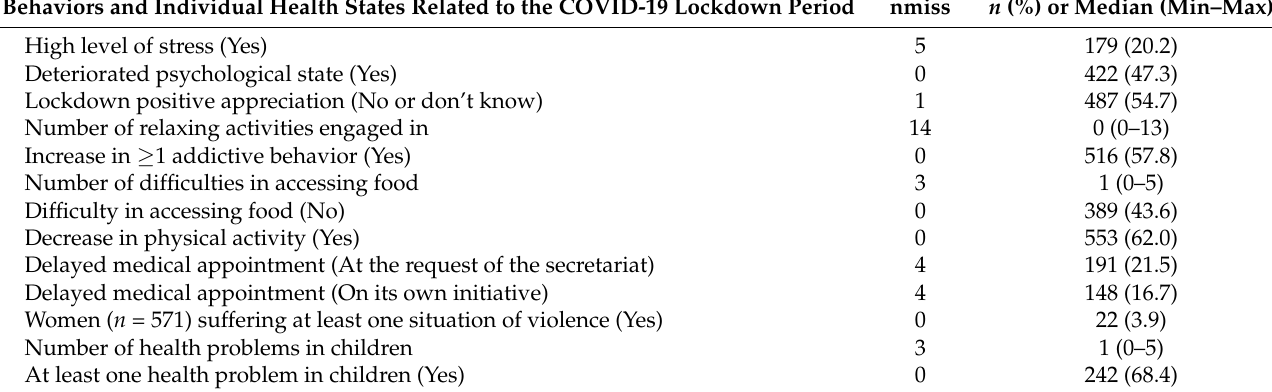
Table 2 completes the description of the study population and reports the study endpoints. Table 2. Endpoints in the R é -Conf-ISS study population (N =